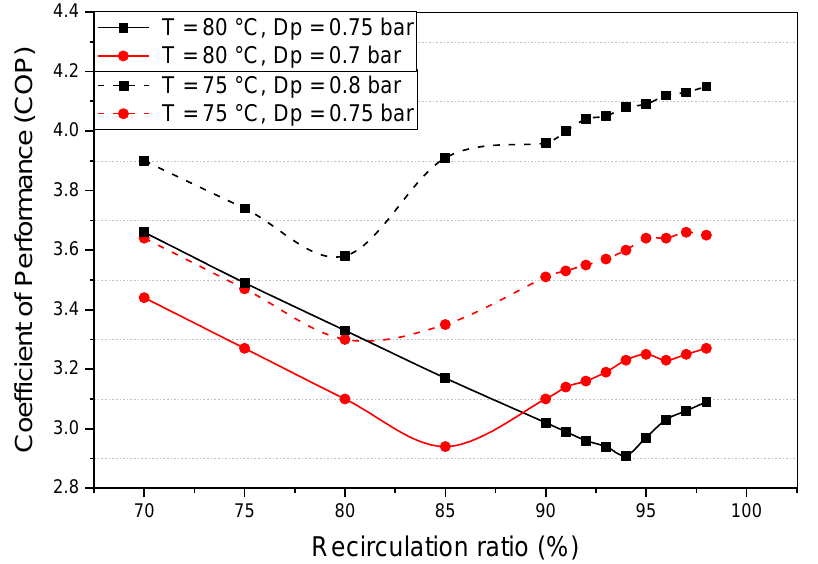
Figure 13. Coefficient of performance (COP) as recirculation ratio increases for ∆ p = 0.7, 0.75 for the set point at 80 ◦ C and ∆ p = 0.75, 0.8 bar for the set-point at 80 ◦ C.